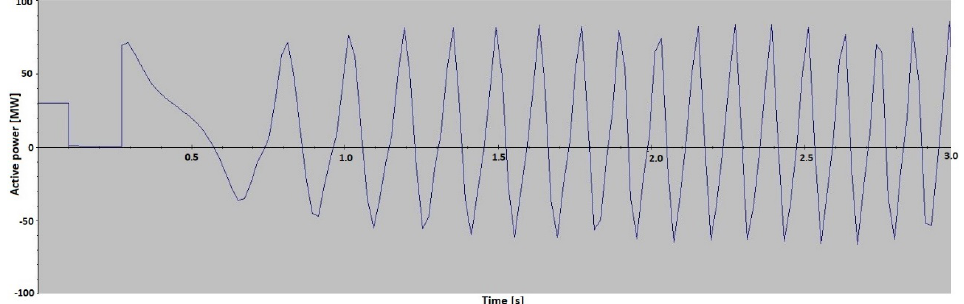
Figure 23. Simulation results of active power of Generator 2 during the three-phase fault with the fault duration of 172 ms.